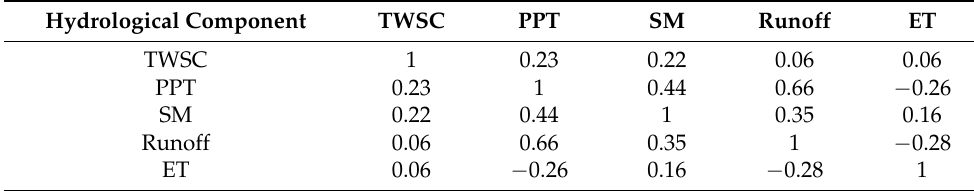
Figure 9. The correlation coefficient and delay months between TWSC, PPT, SM, and runoff anomaly in the LMY. ( a ) TWSC and PPT, SM, runoff; ( b ) PPT and runoff, SM, SM and runoff. Table 3. The correlation coefficients between TWSC, PPT, SM, ET, and runoff anomaly in the UY (these results have passed the 95% confidence level).